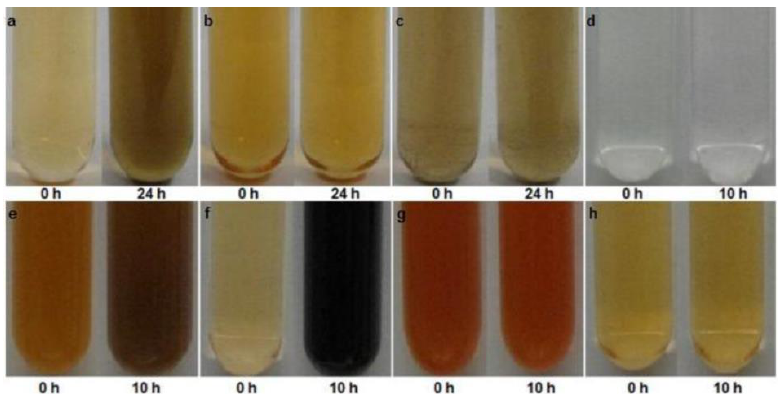
Figure 6. Reductase activity in cellular fractions. ( A ) Cell lysate of strain E1 grown without prior exposure to K 2 TeO 3 . Similar results were found for KR99, E5, RB3, and RB 16-17; ( B ) Lysate of strain E4(1) grown without prior exposure to K 2 TeO 3 ; ( C ) Lysate of E4(1) cells grown with prior exposure to K 2 TeO 3 . Initial darkening at 0 h is due to the trace presence of previously reduced K 2 TeO 3 from prior exposure; ( D ) Periplasmic fraction of KR99 without K 2 TeO 3 exposure. No reductase activity observed. Similar results for E5, E4(1), E1, RB3, and RB 16-17; ( E ) Spheroplast fraction of E1 without prior K 2 TeO 3 exposure containing reductase activity. Similar results for E5, KR99, RB3, and RB 16-17; ( F ) Spheroplast lysate of KR99 without prior K 2 TeO 3 exposure containing reductase activity. Similar results for E5, E1, RB3, and RB 16-17; ( G ) E4(1) spheroplast fraction. No reductase activity observed with or without prior K 2 TeO 3 exposure; ( H ) E4(1) spheroplast lysate. No reductase activity observed with or without prior K 2 TeO 3 exposure. [17].